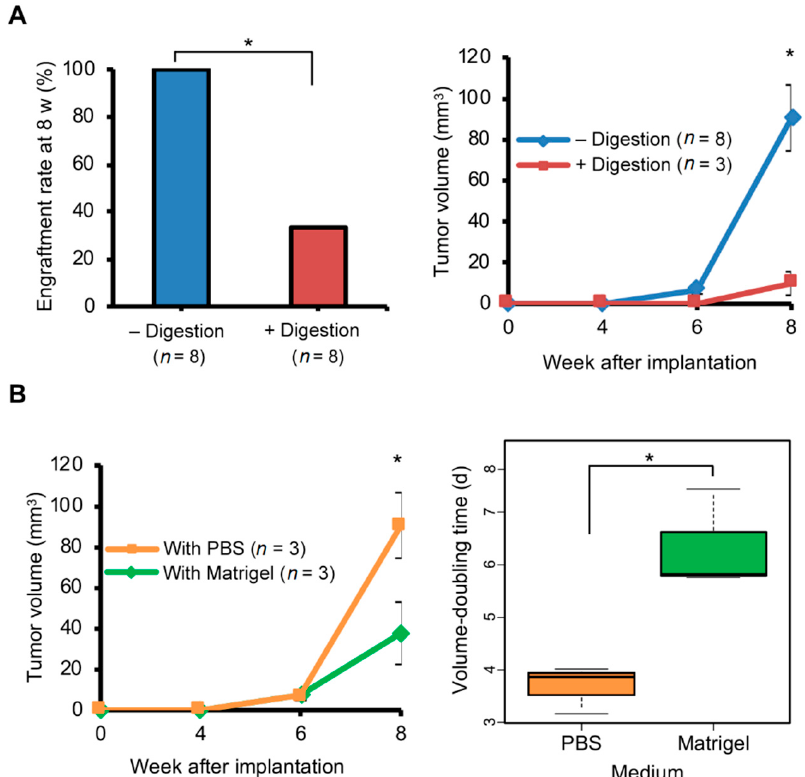
Figure 3. Growth of tumors implanted in the brain is affected by enzymatic digestion and implantation medium. Brain metastasis of one triple negative breast cancer patient that had been passaged three times as xenograft in mouse brain was used for this experiment. All tumor preparations (1 µL tumor with 2 µL phosphate-buffered saline (PBS) or Matrigel) were implanted using the Pipette method, and tumor growth was monitored by magnetic resonance imaging. ( A ) Effect of enzymatic digestion. The engraftment rate at 8 weeks (w) after implantation, and growth over time for engrafted tumors (mean and standard error) are shown for tumors that were either enzymatically digested (+) or not (–) before implantation. PBS was used as medium during implantation. ( B ) Comparison of PBS and Matrigel as medium for tumor implantation. Tumor growth over time for engrafted tumors, and Tukey boxplots of tumor volume-doubling time (days) during weeks 6 and 8 are shown. p values in standard t tests for group comparison are indicated (* ≤ 0.05).